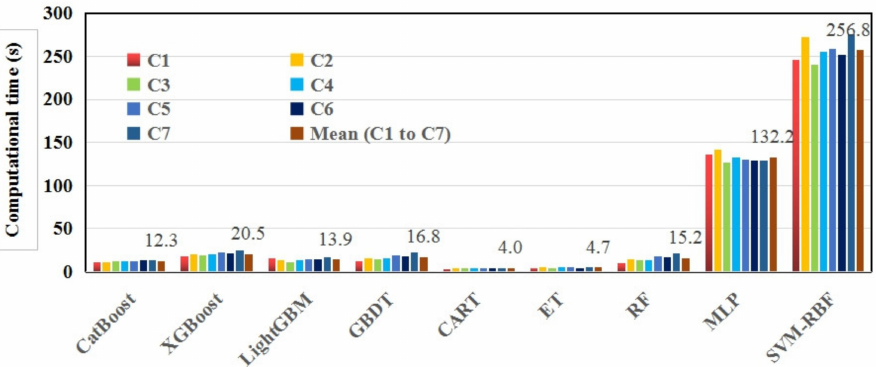
Figure 8. Total comparison of computational time of the nine models under seven input combinations for all stations and all training stages (C1: R a , n/N ; C2: R a , n/N, T max , T min ; C3: R a , n/N, H r , U 2 ; C4: R a , n/N, P re , P rs ; C5: R a , n/N, T max , T min , H r , U 2 ; C6: R a , n/N, T max , T min , P re , P rs ; C7: R a , n/N, T max , T min , H r , U 10 , P re , P rs